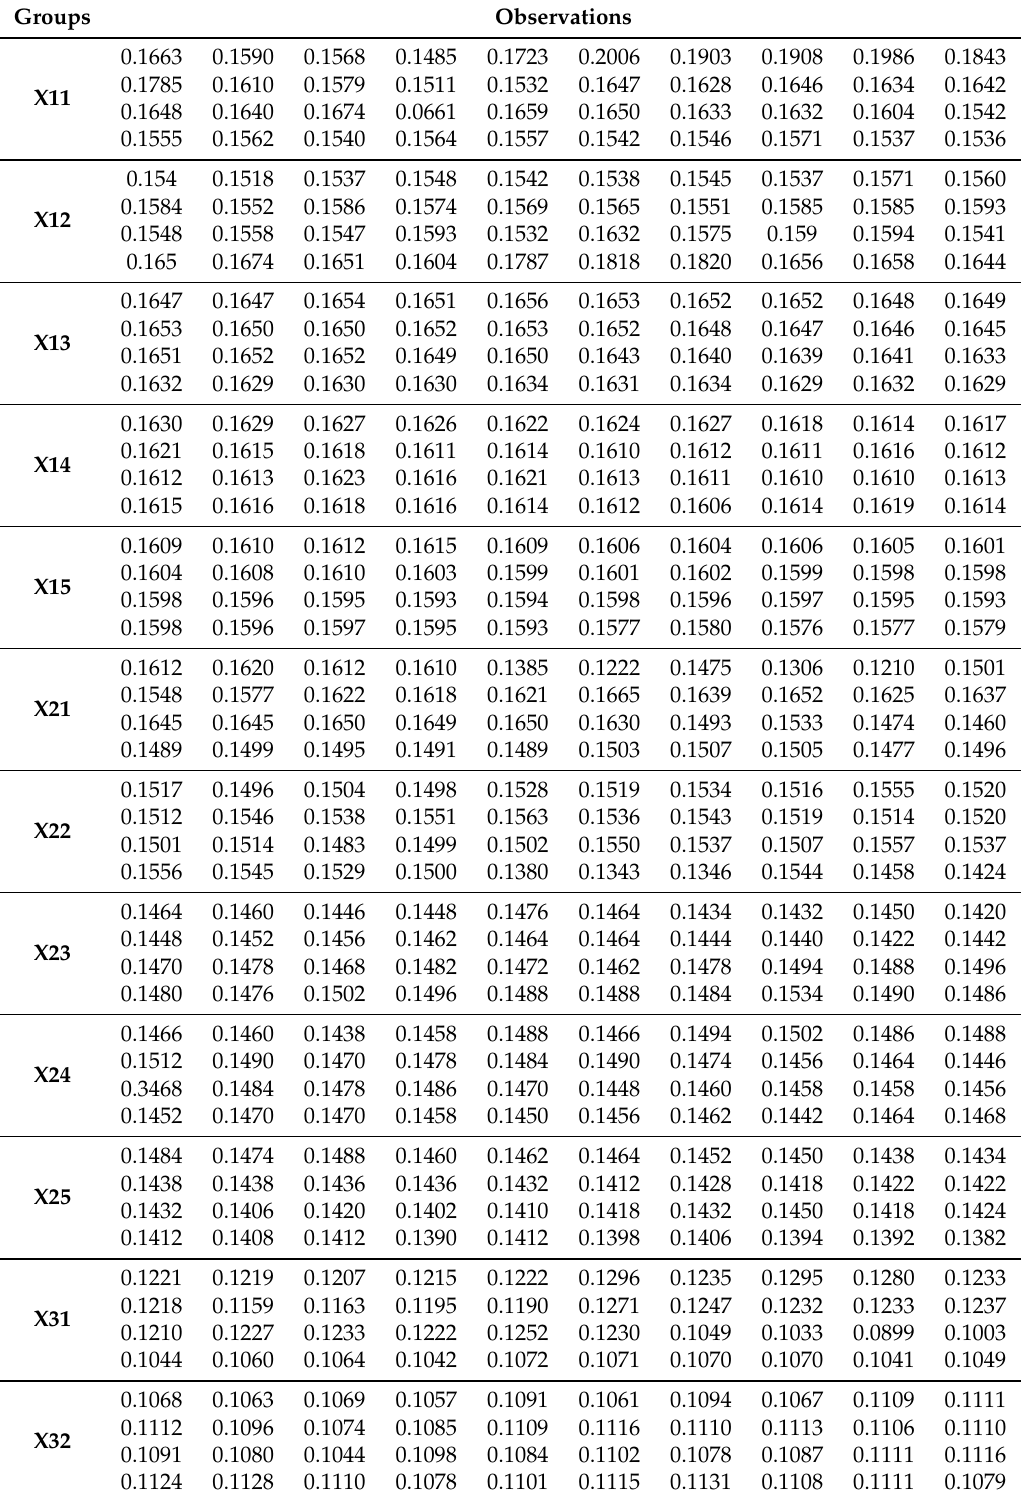
Table A1. Experimental data of fault diagnosis